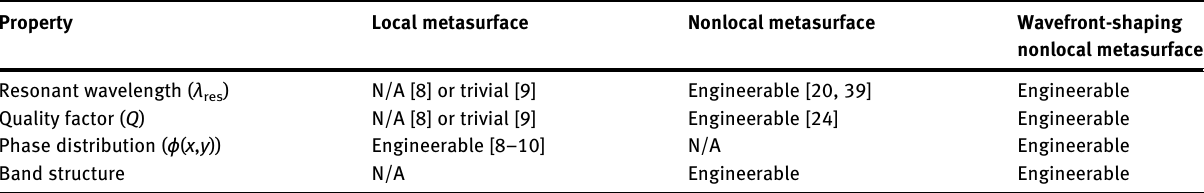
Table  : Comparison of properties tuned by mechanical strain.